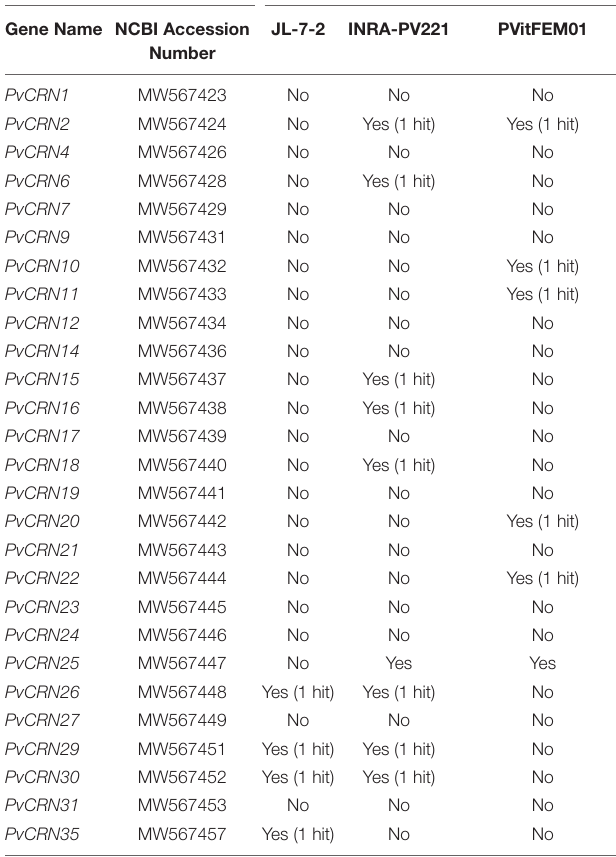
TABLE 1 | DNA sequence identity analysis of PvCRN genes in four P. viticola isolates. PvCRN genes in P. viticola YL Presence of orthologs with 100%